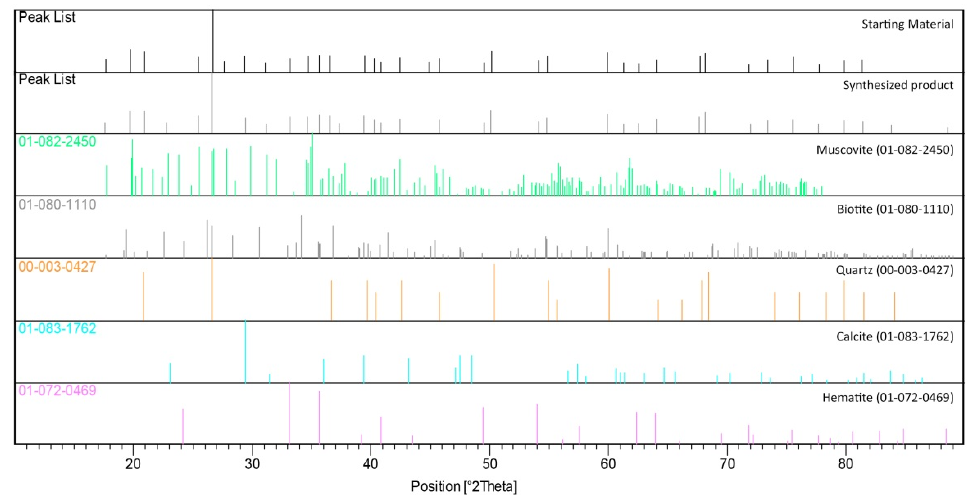
Figure A1. Experimental XRD patterns vs. reference patterns of the starting material and synthesized product . Table A1. Major and minor phases in the starting material and synthesized product.